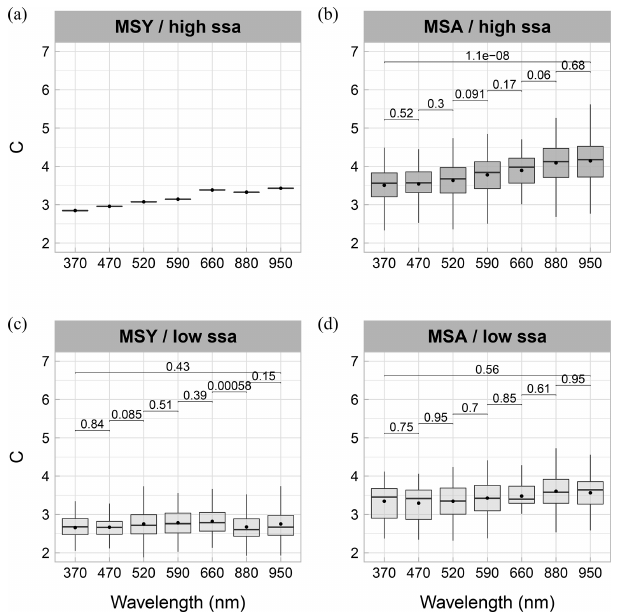
Figure 5. Wavelength dependence of C at MSY (a, c) and MSA (b, d) obtained comparing b atn from the AE33 measured at each wave- length and b abs interpolated and extrapolated to the same wave- length from PP_UniMI. Box plots have been obtained as in Fig. 3 and separated into two categories depending on whether the SSA was above (“high ssa”; a , b ) or below (“low ssa”; c , d ) the threshold at which C sharply increases. As in Fig. 3, the values above the box plots between adjacent wavelengths and between 370 and 950nm wavelength box plots show the obtained p values, with p < 0 . 05 meaning a statistically significant difference.